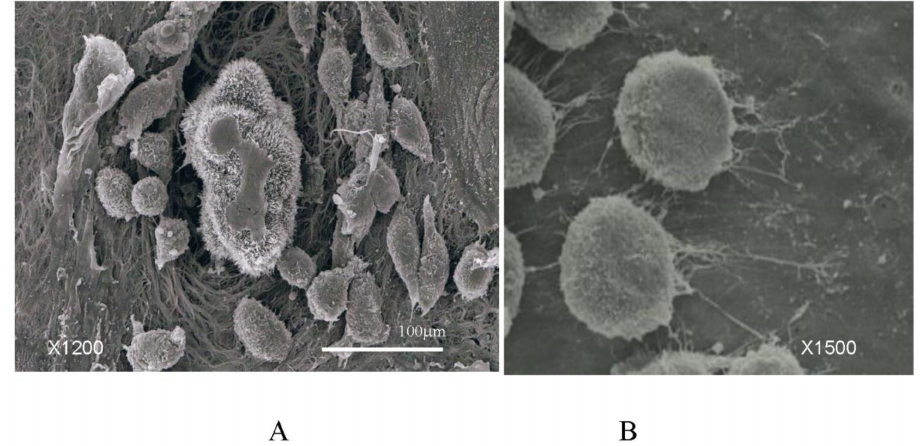
Figure 15. ( A ) Cluster of cancer cells attach to areas of the basement membrane exposed by shrinkage of mesothelial cells. ( B ) Micro villi extending from PFCCs attach to the basement membrane of the greater omentum. SEM finding of human gastric cancer cell line of MKN-45 that was co-cultured with human greater omentum for 2